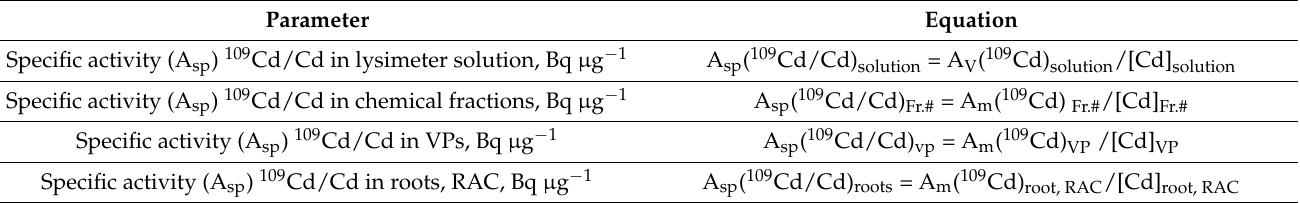
Table 3. Parameters of specific activity Cd/ 109 Cd in lysimeter waters, soil, VPs, roots and RAC.